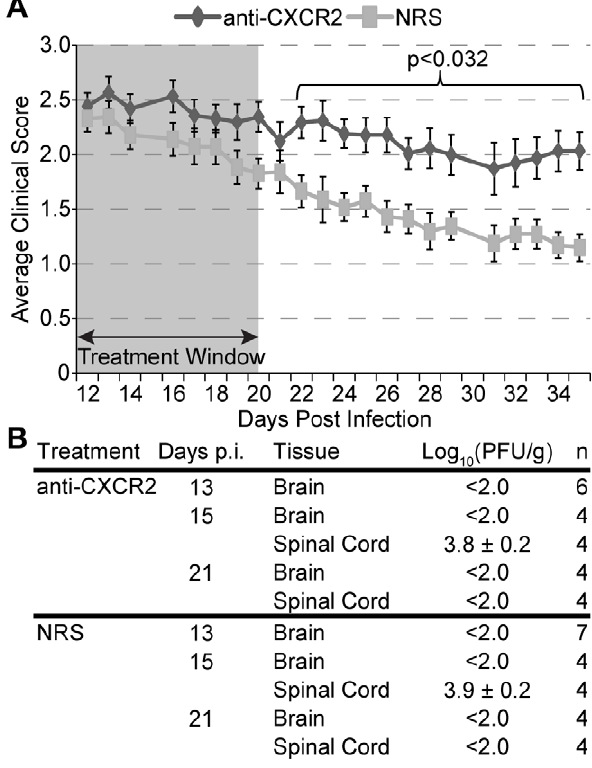
Figure 2. CXCR2 neutralization mutes spontaneous recovery from JHMV induced demyelination. C57BL/6 mice were i.c. infected with 500 pfu JHMV and treated with neutralizing CXCR2 antiserum or control normal rabbit serum (NRS) i.p. from day 12 to 20, indicated by the shaded box. Treated mice were allowed to recover for a further two weeks and clinical severity was assessed ( A ). In addition, brains and spinal cords from treated mice were removed at the beginning, middle, and end of treatment to assess JHMV viral burden ( B ). For panel A data is a summation of four independent experiments (anti-CXCR2 n=32; NRS n=31). For panel B data is a summation of two independent experiments.